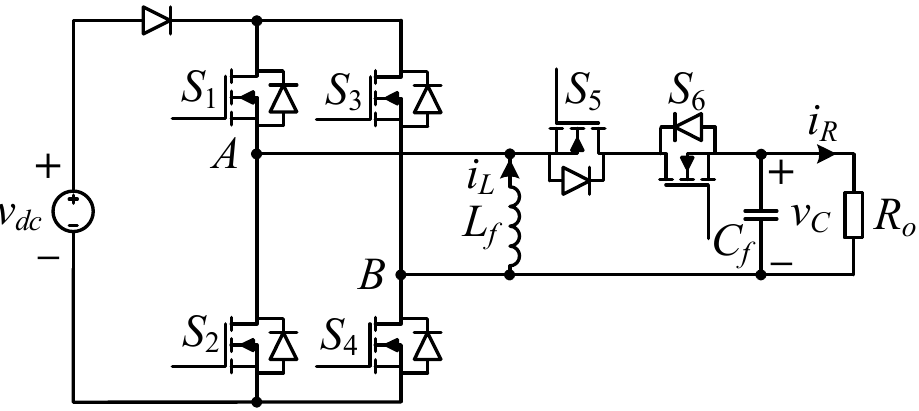
Figure 1. Schematic diagram of the proposed single-stage transformerless buck–boost inverter system.